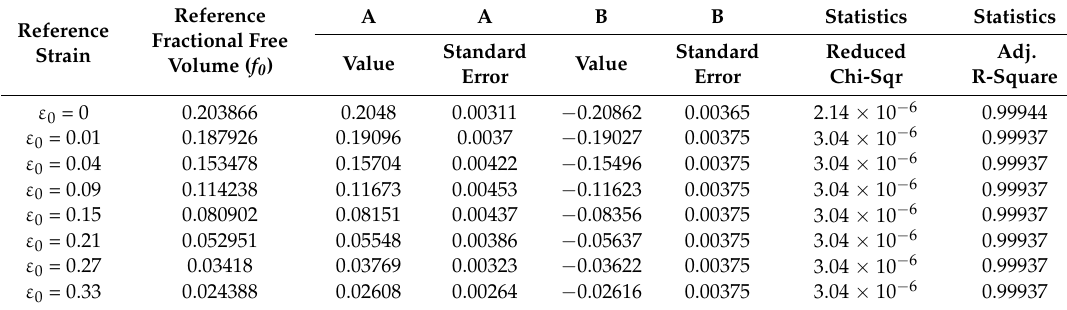
Table 1. Goodness-of-fit check.